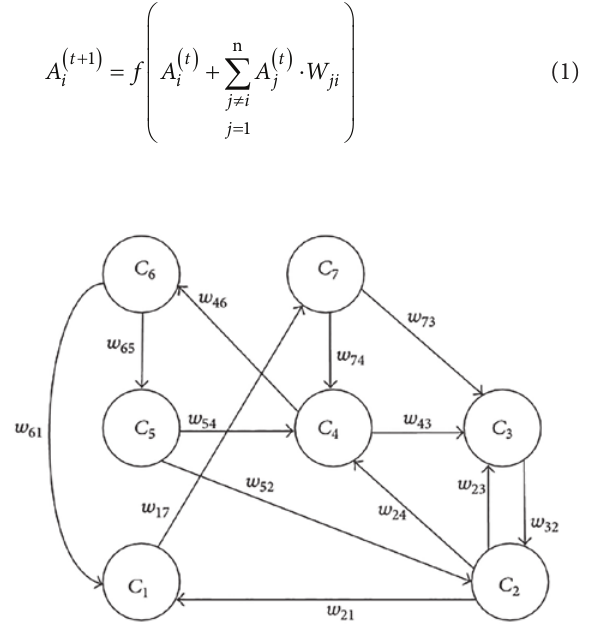
Figure 1. Example of a fuzzy cognitive map (source: Z. Peng, J. Peng, Zhao, & Chen (2015, p.